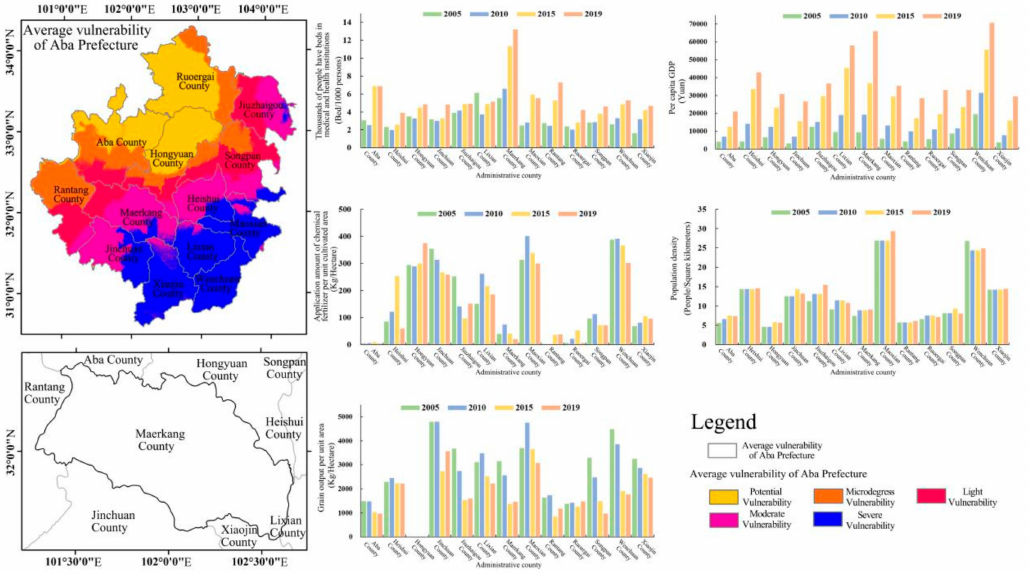
Figure 9. Spatial distribution of socio-ecological vulnerability in Maerkang City, 2005–2019.